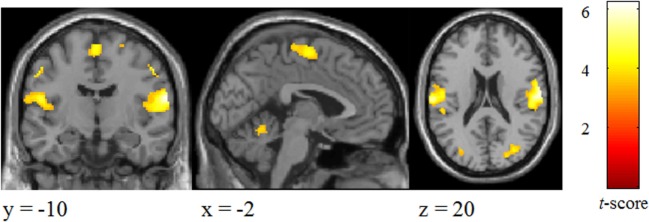
Brain areas activated by tactile stimuli for all two emotional conditions in participants.